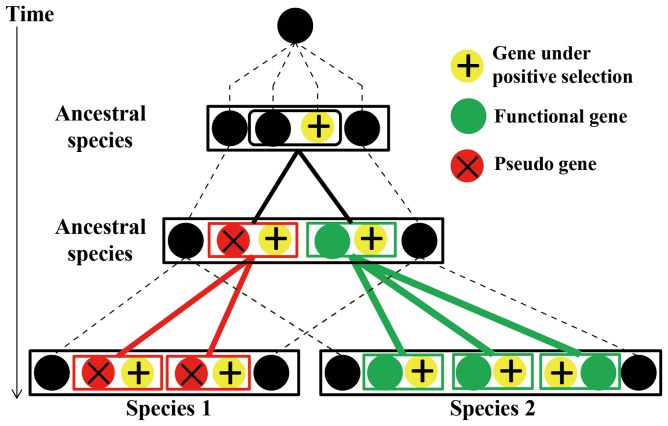
The less-is-hitchhiking hypothesis during the birth-and-death evolution of multigene families.With the expansion of the gene (driver) under positive selection, the adjacent linked gene (hitchhiker) is duplicated in the process of segmental duplication. Pseudogenization of the hitchhiker occurs in an ancestral species following the duplication process. During the process of birth-and-death evolution, the hitchhiker that gains more copies can be either the pseudogene or the functional gene with the other one being lost, and the gain or loss of the hitchhiker is determined by the fitness of its adjacent driver. The expansion of the pseudogene and loss of the functional gene scenario is defined as the less-is-hitchhiking hypothesis.